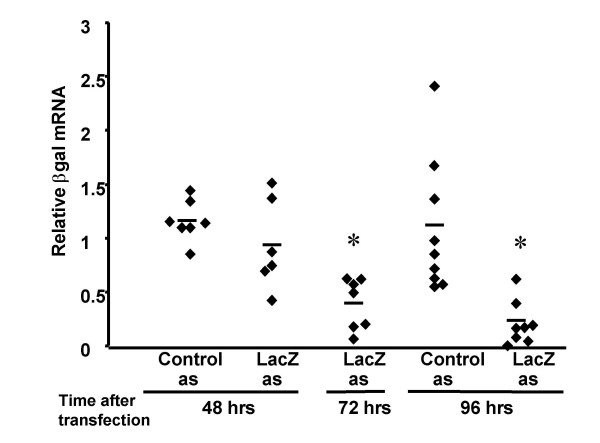
βgal mRNA in vivo lung transfection of K18-lacZ with lacZ asODN. LacZ asODN (as4) or a control ODN was complexed to GL67 (160 μg/mouse), placed as a bolus (100 μl) onto the nostrils of anaesthetised mice and "sniffed" into the lung. Forty-eight to 96 hours after transfection the lungs were harvested and β-gal mRNA was quantified. Each diamond represents an individual animal. The mean per group is indicated as a horizontal bar. * indicates p < 0.05 when compared to control group.